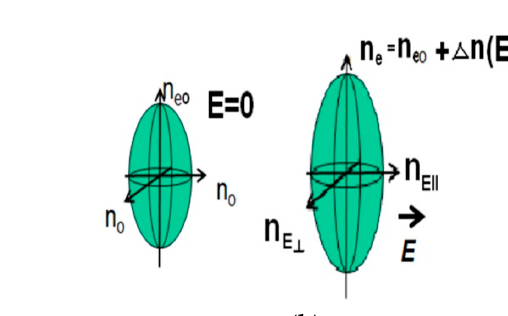
(right) of electric field [40]. electric field